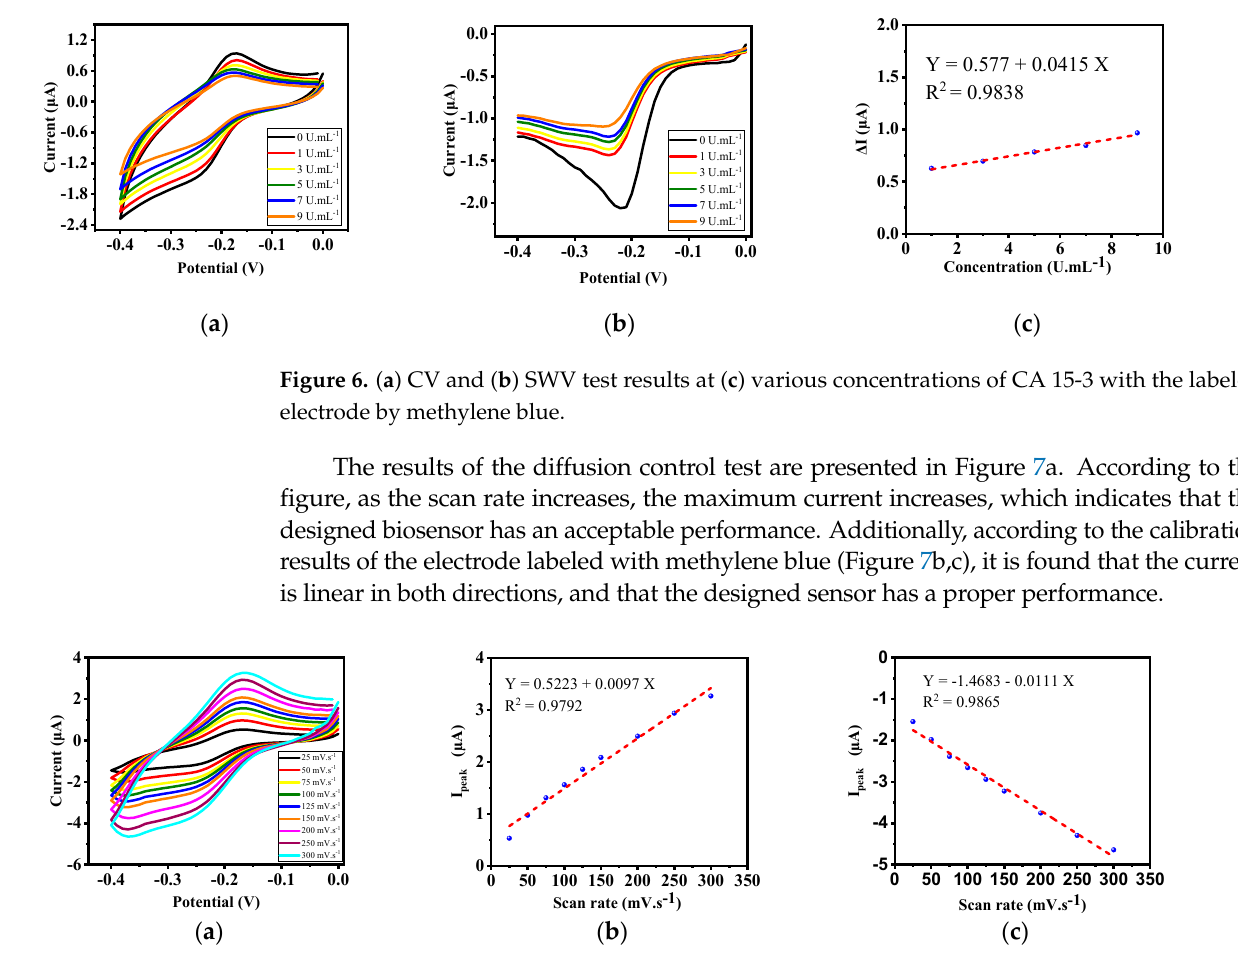
Figure 7. ( a ) Diffusion control test of the electrode labeled by methylene blue. ( b ) Calibration curve of diffusion control test of the electrode labeled by methylene blue in the reduction path. ( c ) Calibration curve of diffusion control test of the electrode labeled by methylene blue in the oxidation path.